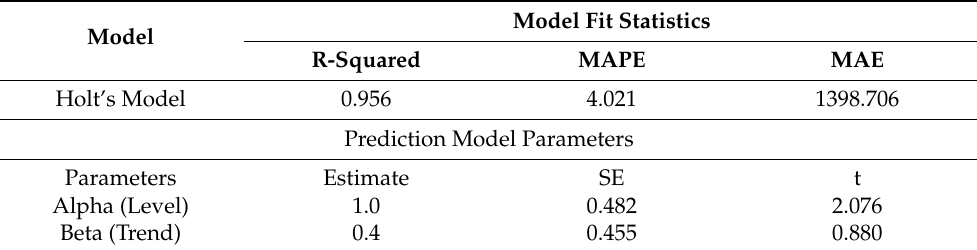
Table 1. Statistics and parameters of developed